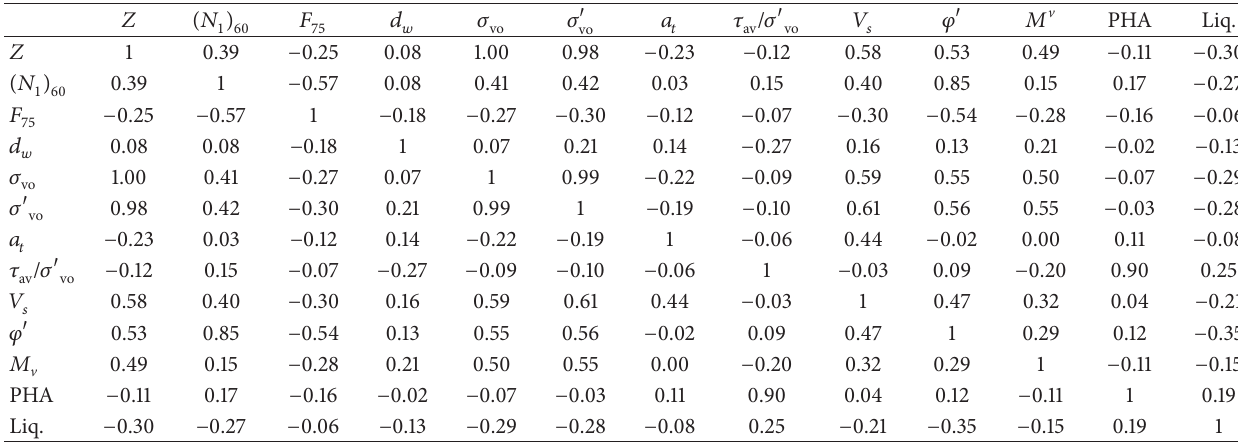
Table 3: Correlation matrix.